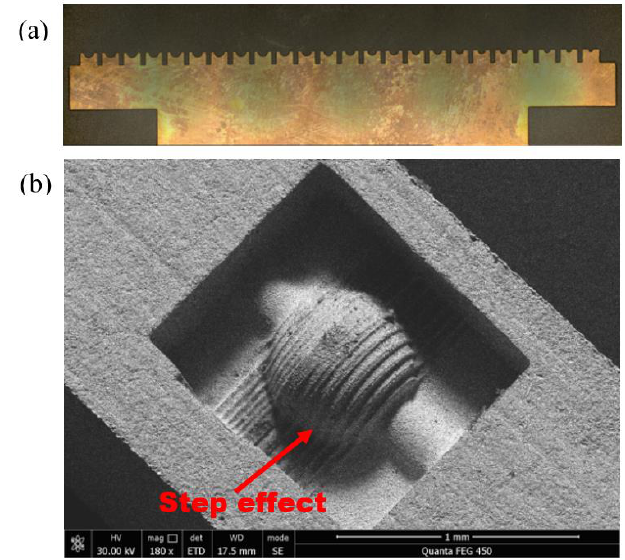
Figure 1. ( a ) Foil queue (FQ)-microelectrode; ( b ) 3D microstructure fabricated by the micro-electrical discharge machining (EDM) of FQ-microelectrode.